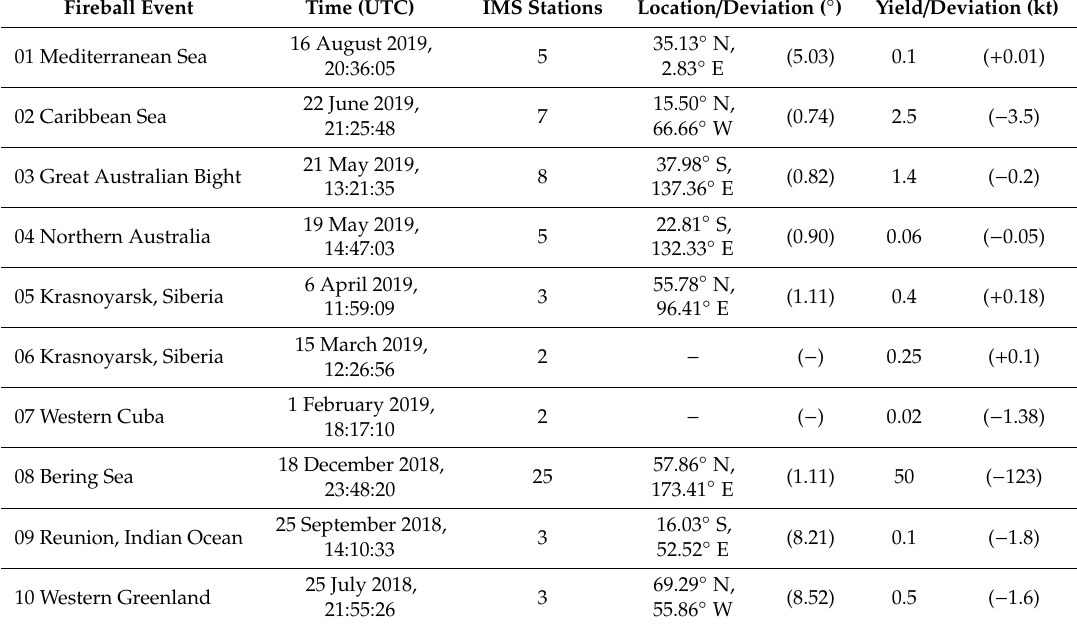
Table 1. Localization and yield estimation for the 10 fireball events analyzed within this study using infrasound array recordings. Values in brackets quantify the deviation from the CNEOS